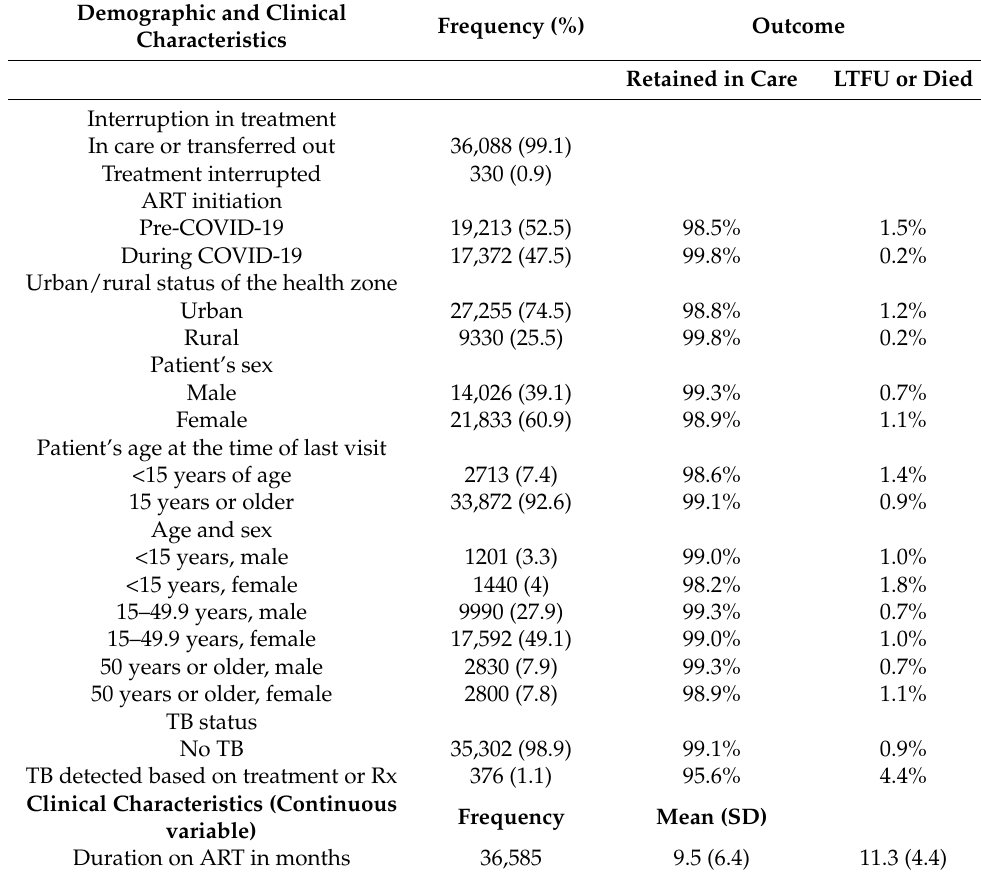
Table 1. Descriptive statistics by retention status for patients in HIV/AIDS clinics of Haut-Katanga and Kinshasa provinces, DRC, who initiated ART between 1 April 2019 and 30 March